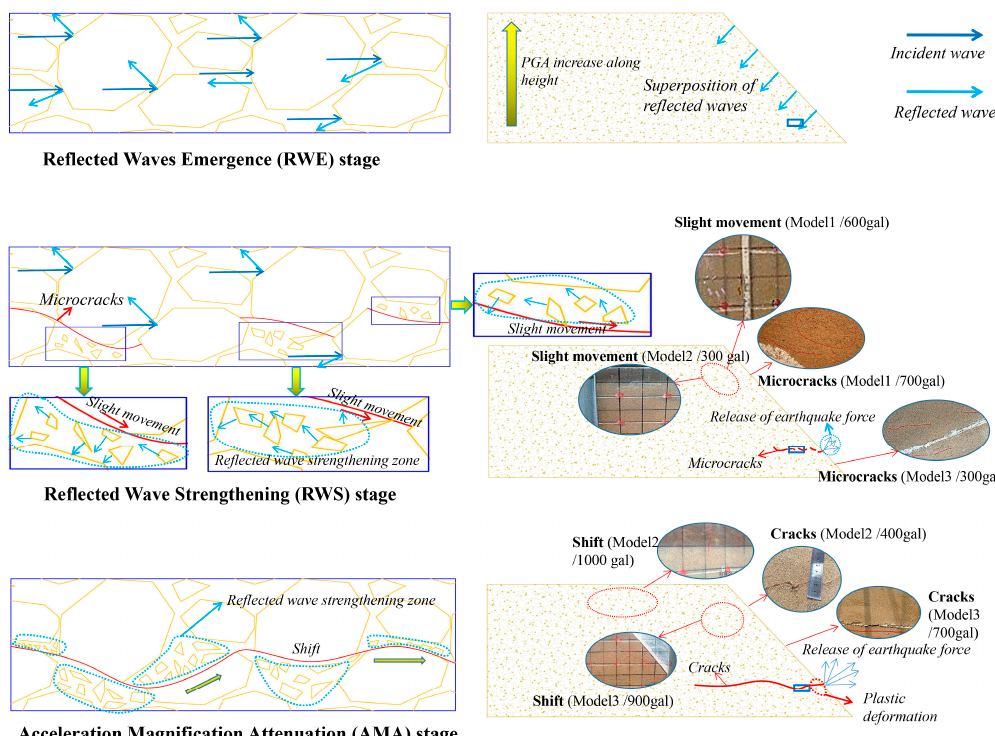
Figure 11. Three stages of destruction in shaking table tests.